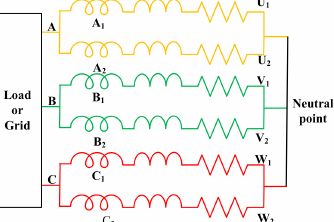
Figure 3. Schematic diagram of a double Y-shaped connection of the stator winding. In Figure 3, U 1 U 2 is the two branches of the A-phase winding. V 1 V 2 is the two branches of the B-phase winding. W 1 W 2 is the two branches of the C-phase winding. Using the knowledge of electrical machinery, the high order and small amplitude harmonics can be ignored, and the instantaneous value of the induced electromotive force of a single parallel branch of the generator stator winding is determined as